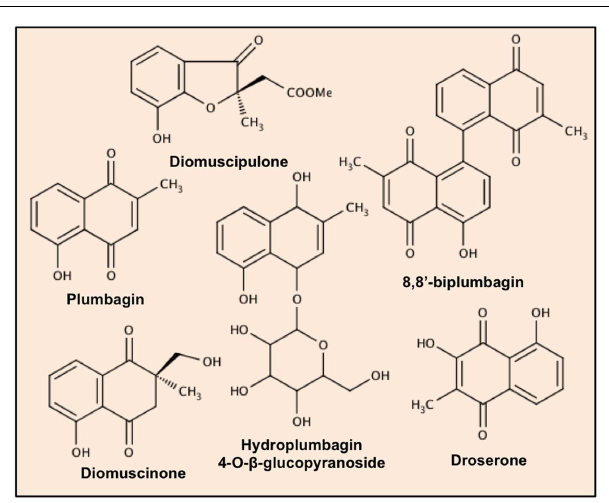
FIGURE 2 | Chemical structures of molecules present in Dionaea muscipula Solander ex Ellis . Compounds are arranged according to the following classification: phenolic compounds in blue, flavonoids in green, and naphthoquinones in